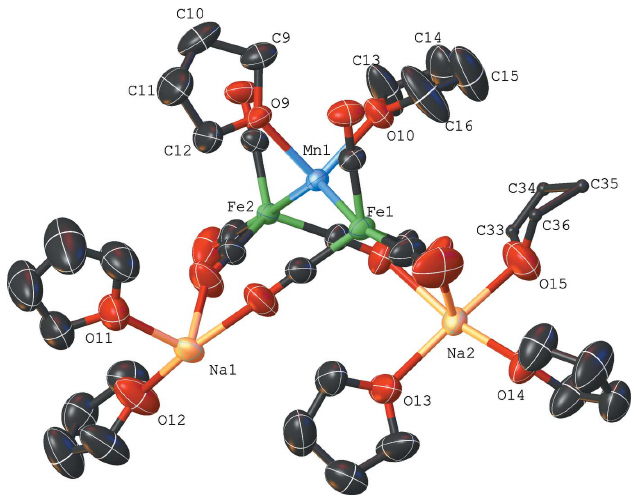
Figure 1 The asymmetric unit of the title compound, with displacement ellipsoids drawn at the 50% probability level. One tetrahydrofuran molecule coordinating Na2 is statistically disordered. For clarity, atoms C33–C36 are shown isotropically with a 50% probability level and atoms C33 A – C36 A are not shown.